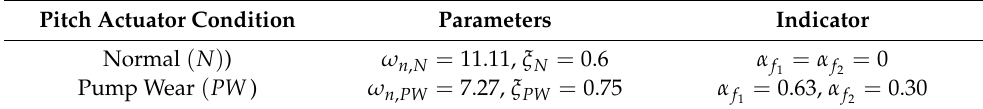
Table 1. Pitch actuator dynamic change parameters [1,6].